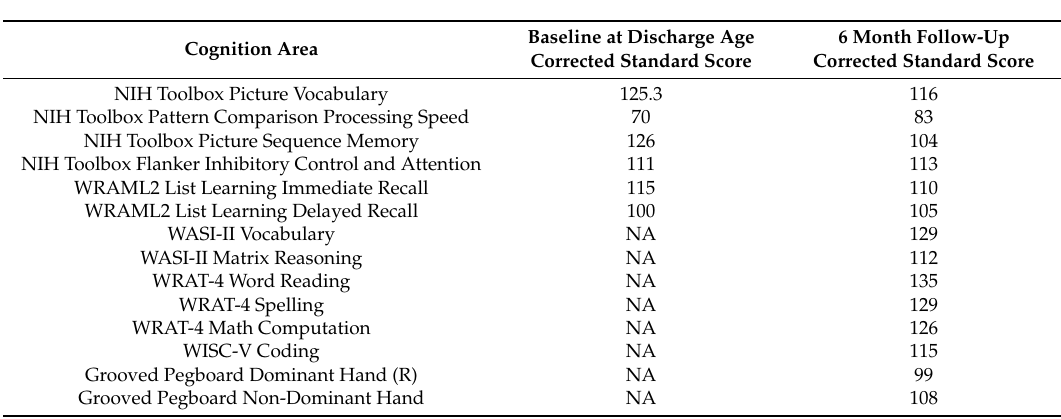
Table 2. Case Study Neuropsychological Assessment